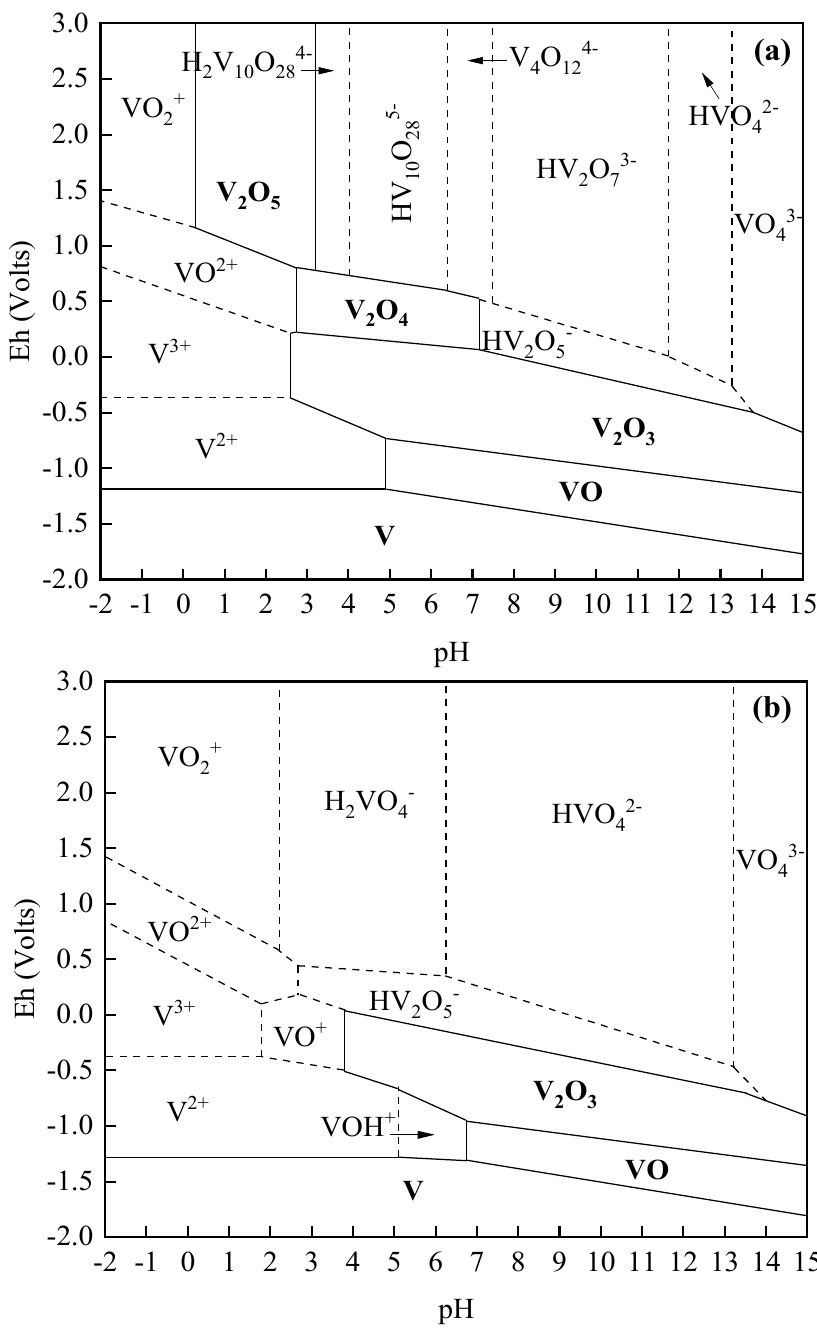
Figure 10. Potential pH diagram in vanadium water system at 25 ◦ C: ( a ) a = 10 − 1 ; ( b ) a = 10 − 5 . When the pH of the solution is low, the +4-valent vanadium element mainly exists in the form of vanadyl VO 2+ ; when the pH in the system is greater than 3, VO 2+ will deposit into V 2 O 4 as solid phase; increase the pH of the solution again, and the V 2 O 4 of the solid phase will dissolve again to form the anion HV 2 O 5 − . When pH in the system is less than 3, the solution containing +3-valence vanadium is blue-green in color and exists in the form of V 3+ ions. Increasing the pH of the solution will generate solid V 2 O 3 , which is because V 2 O 3 is more stable than V(OH) 3 . Comparing (a) and (b) in Figure 10, it can be seen that when the pH in the solution is less than 3, vanadium mainly exists in the form of cations; when pH > 3.5, vanadium in the system mainly exists in the form of anions. When the vanadium activities in the system